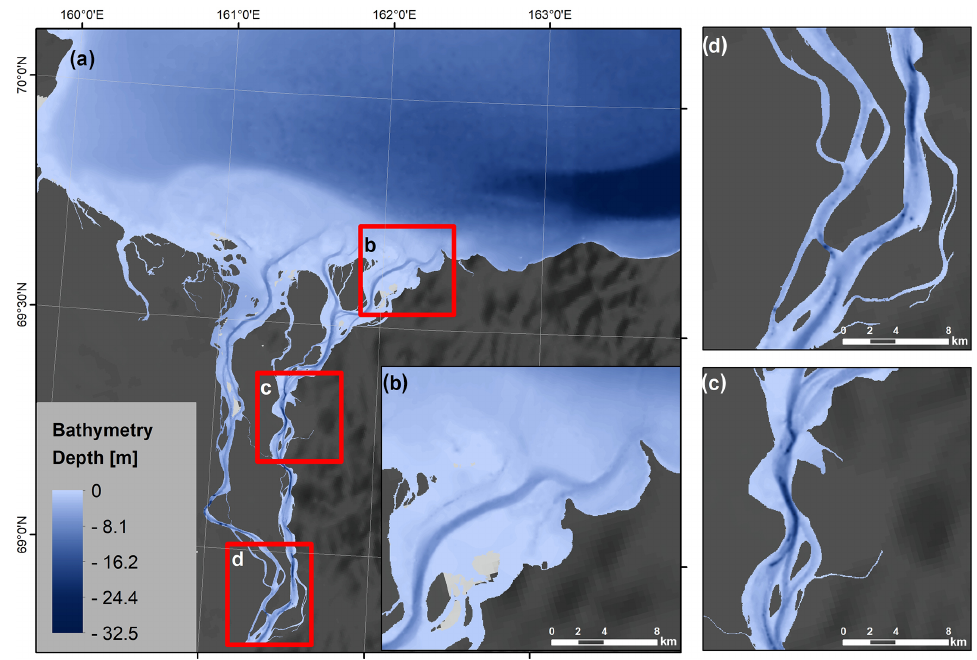
Figure 5. (a) Topo-to-Raster-modeled bathymetry (TTR 50 ) of the Kolyma Gulf region with three zoomed-in subsets of the Kolyma River mouth (b) in the central Kolyma Gulf showing one of the deepest parts of the main river channel (c) and at the apex point of the Kolyma Gulf region (d) , where the two main channels split.